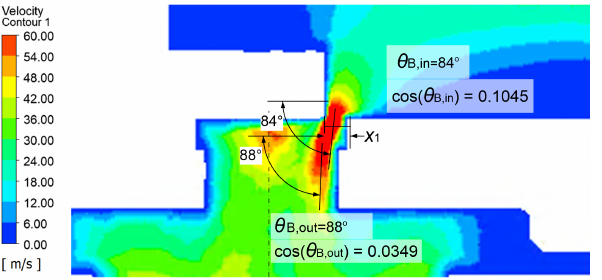
Figure 10. CFD results for different loads on both outputs in longitudinal cross-section: ( a ) pressure distribution, ( b ) velocity distribution; P, A, B—connection ports.